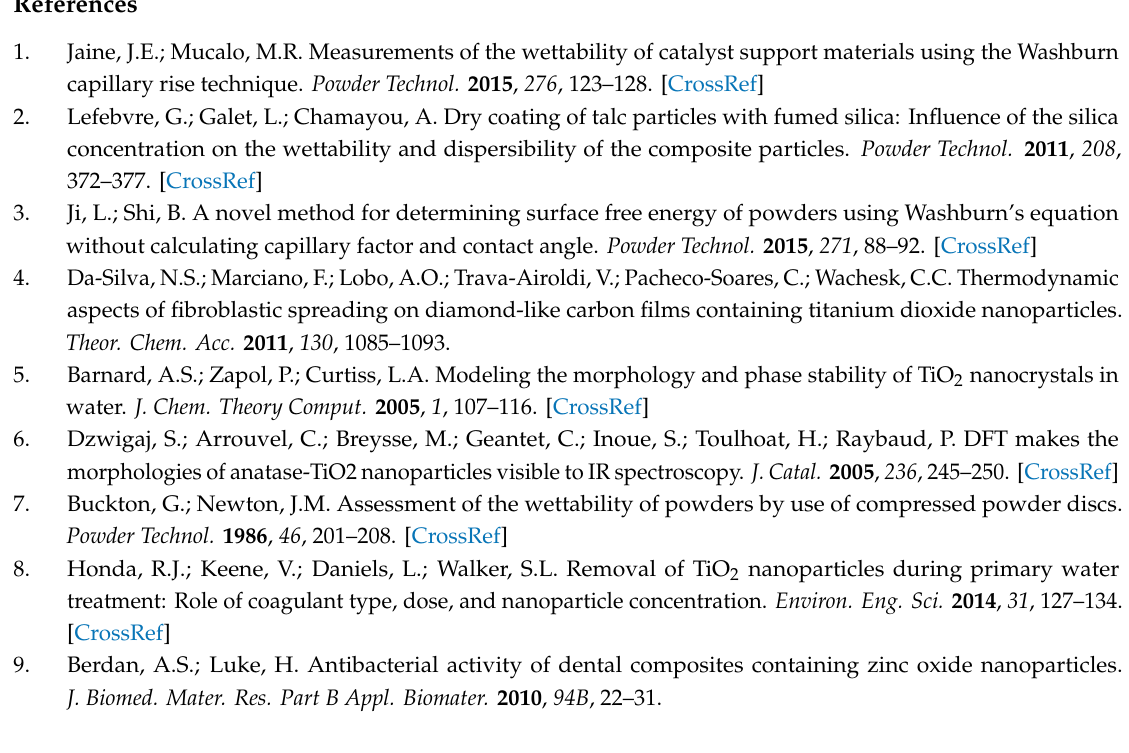
Table S1: Summary of dosing volume and rate for solvents in CA goniometer, Table S2: Summary of contact angles determined from the modified-DPM, Table S3: Summary of methods used for contact angle measurements in